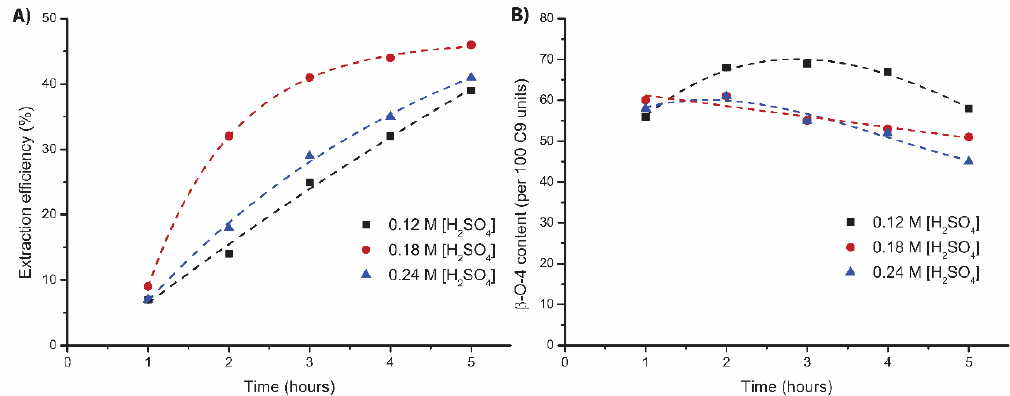
Figure 4. Influence of the different H 2 SO 4 concentrations on the mild organosolv extraction * (80:20 EtOH/H 2 O, 120 °C, 5 h) on ( A ) extraction efficiency (corrected for alcohol incorporation as determined by 2D HSQC) and ( B ) total β-O-4 content as determined by 2D HSQC. * Different walnut source than starting point experiment.